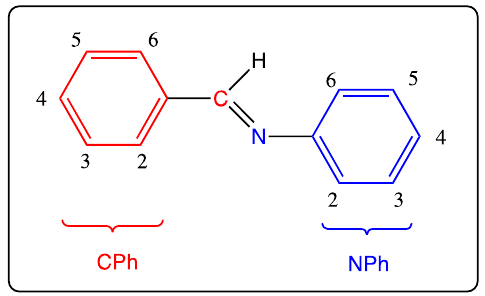
Figure 7. Symbolism for analysis of NMR data.